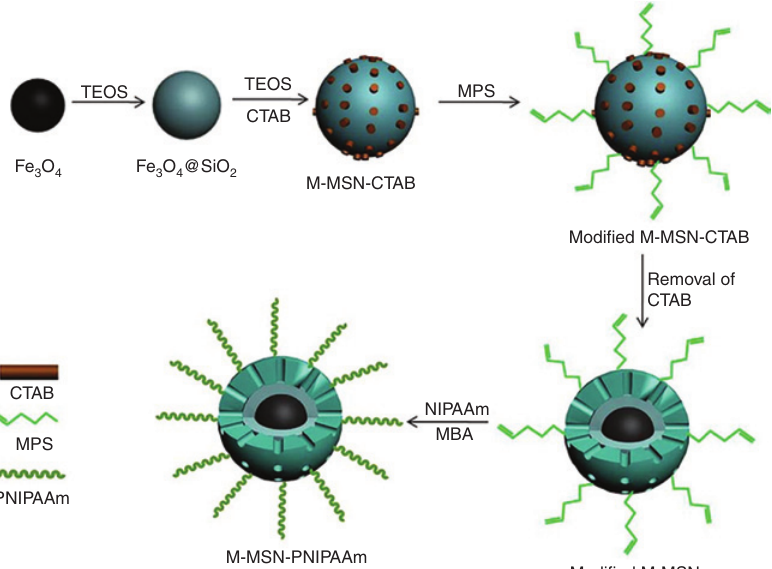
Figure 7: Schematic illustration of M-MSN-PNIPAAm preparation, functionalization, and drug release mechanism. Reused from Reference [72] with permission of John Wiley and Sons’